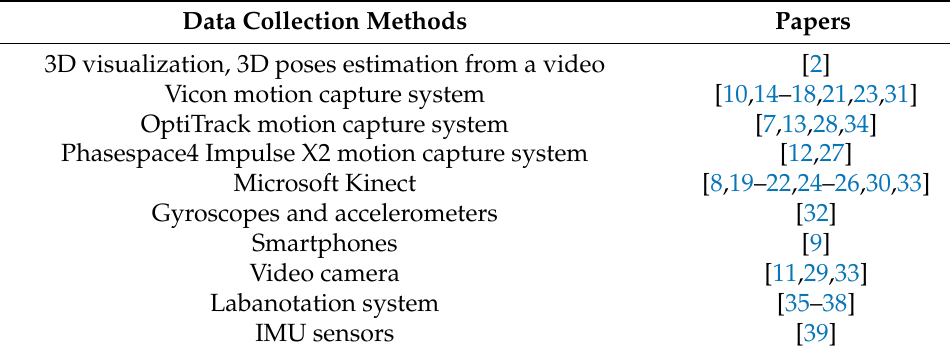
Table 2. Technologies used to capture traditional dance data. Data Collection